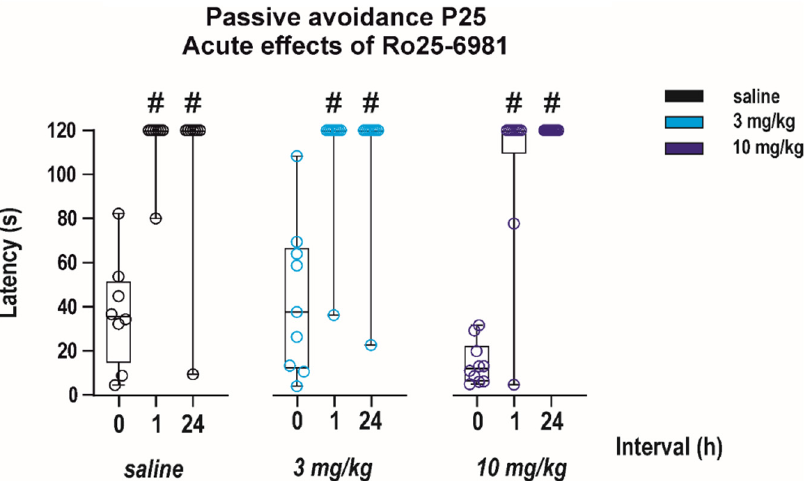
Figure 6. Effects of a single administration of Ro25-6981 on performance in the passive avoidance test. The drug was administered in two doses (3 or 10 mg/kg i.p.) to P25 animals 30 min before the 1st exposure (interval 0; x axis) and the test was repeated two times—1 and 24 h after the 1st exposure. Experimental groups consisted of 8–9 animals. Neither tested dose of Ro25-6981 affected latencies to step through (in seconds; y axis). # denotes the significant difference in latencies to step through between the 1st and repeated tests. All details and symbols as in Figure 4.